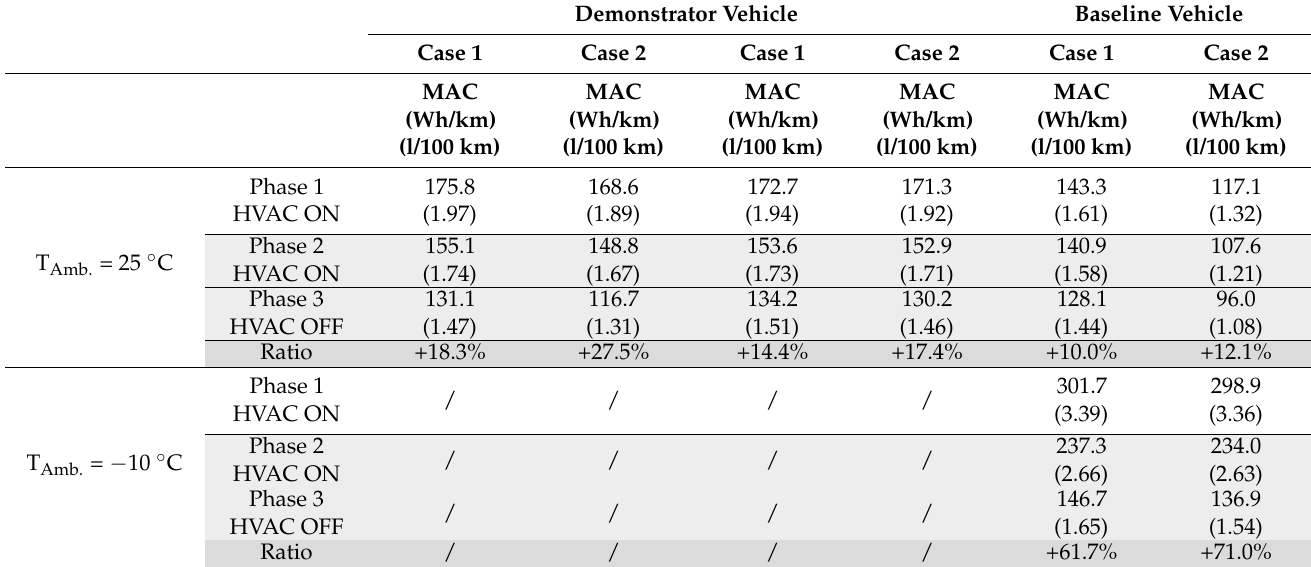
Table 7. Energy consumption results